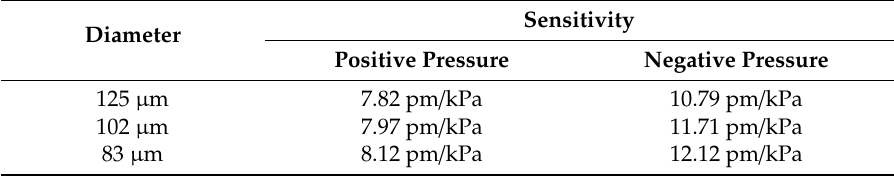
Table 1. Sensitivity of di ff erent diameter fiber Bragg grating (FBG) sensors under positive and negative pressure.